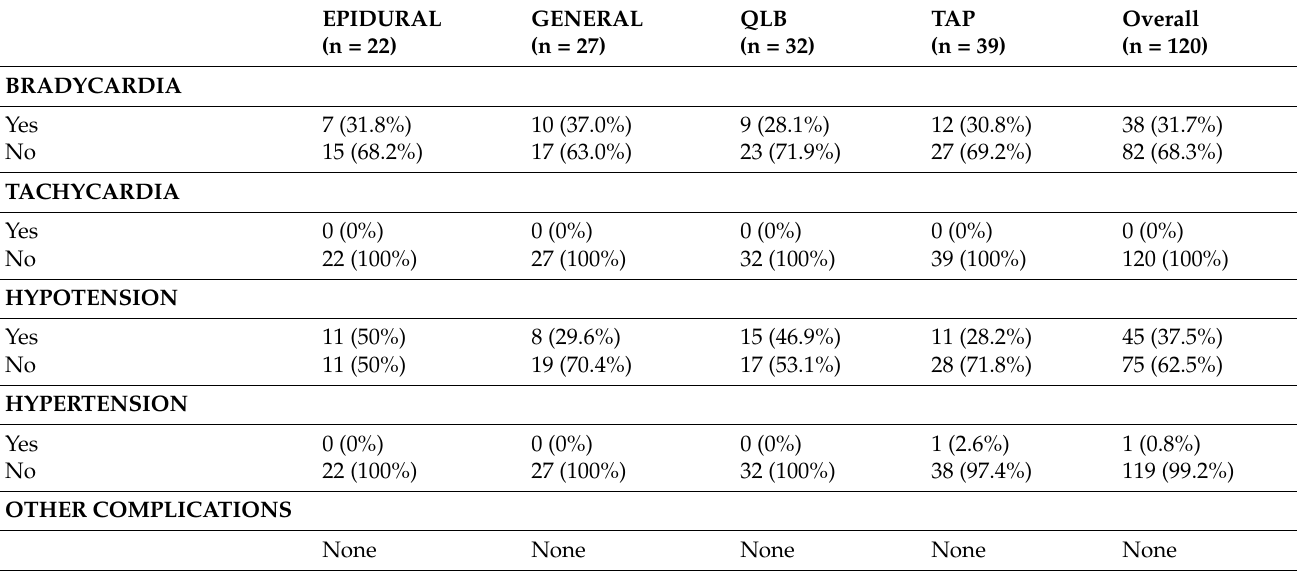
Table 5. Number and percentage of complications found in each group. No significant differ- ences were found among the groups, although the total number of complications was very low. No complications were found related to the realization locoregional anaesthesia